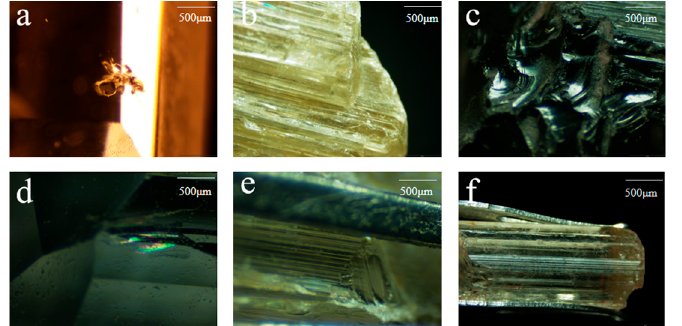
Figure 4. Surface and internal characteristics of scapolite. ( a ) Corresponding to cl-1, ( b ) corresponding to y-15, ( c ) corresponding to y-4, ( d ) corresponding to cl-2, ( e ) corresponding to y-6, ( f ) corresponding to y-13. Table 1. Conventional gemological properties of scapolite.